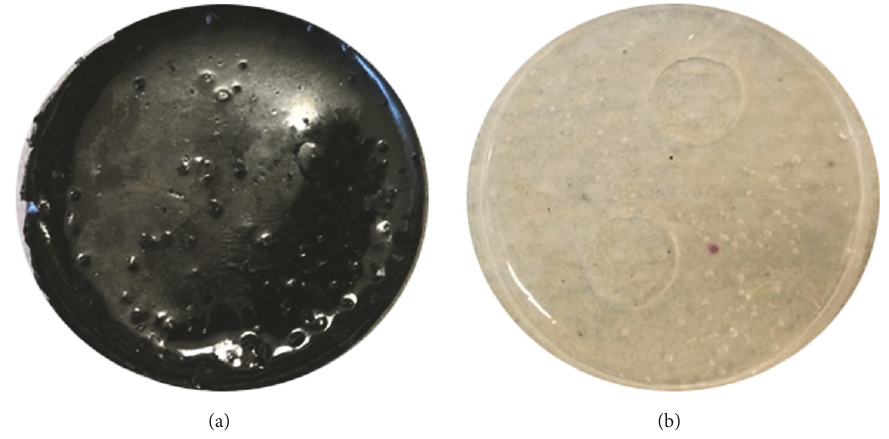
Figure 4: Fabricated silicone-based substrates with high CNTs (a) and no CNTs